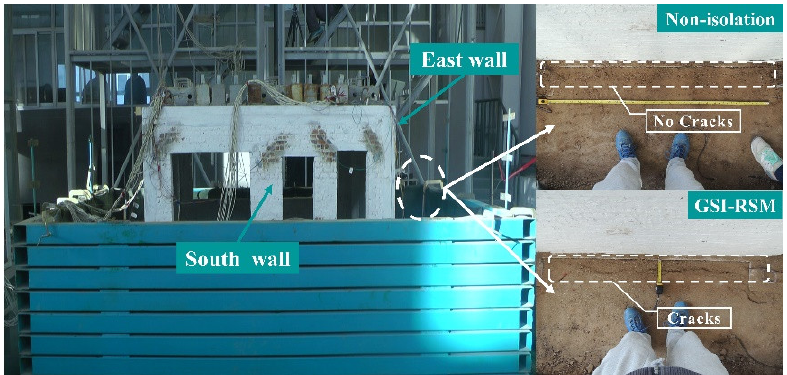
Figure 14. Backfill cracks of models.